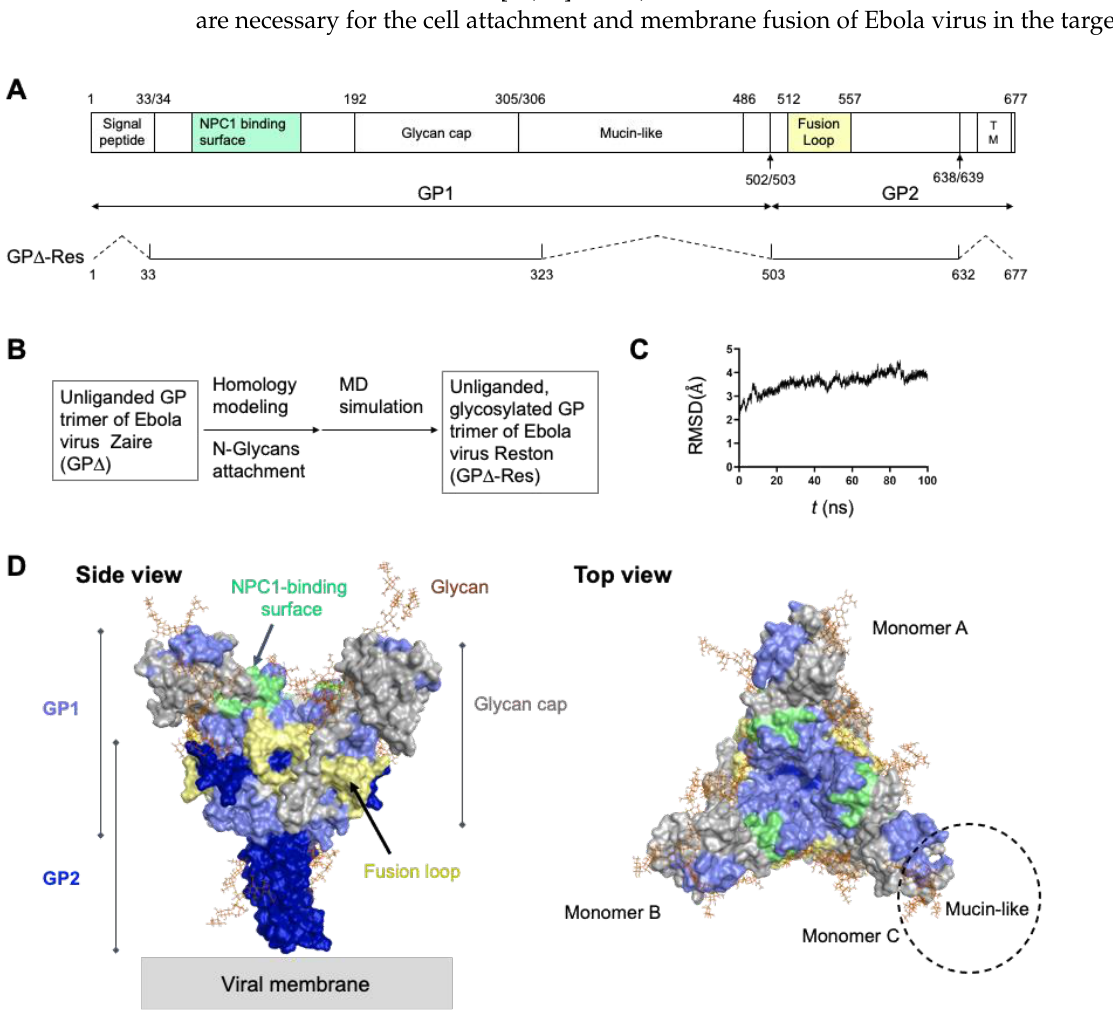
Figure 6. Molecular modeling of the unliganded, pre-fusion state of the glycosylated GPΔ -Res trimer of the Reston Ebola virus strain. The reported amino acid sequence of the spike glycoprotein of the Reston Ebola virus strain (GenBank accession number: AAC54885)[43] and the reported crystal structure of the ectodomain of the unliganded glycoprotein trimer of the Zaire Ebola virus strain at a resolution of 2.23 Å (PDB code: 5JQ3) [47] were used to construct a structural model of the GPΔ -Res trimer of the Reston Ebola virus strain by homology modeling followed by MD simulation, as described for the modeling of the trimeric envelope glycoproteins of other RNA viruses [44 – 46]. Gal 2 Man 3 GlcNAc 4 was added on the trimeric glycoprotein model before MD simulation based on previously reported information [48] using the Online Glycoprotein Builder web-tool GLYCAM-Web [49]. ( A ) Schematic of the structural organization of the Ebola virus glycoprotein. Dotted lines indicate regions absent in the modeling template GP Δ [47] and the Reston Ebola virus glycoprotein model (GP Δ -Res). Amino acid numbering is based on the Reston glycoprotein. ( B ) Overview of the GP Δ -Res modeling. ( C ) Root mean square deviations (RMSDs) between the initial model structure and the structures at given time points during the MD simulation. ( D ) Molecular surface model of a GP Δ -Res structure at 100 ns of MD simulations. Mucin- like domain is located on the frontal region of glycan cap of each glycoprotein monomer [93]. Light green and yellow portions indicate the binding surface of endosomal protein Neimann – Pick C1 (NPC1) and fusion loop, respectively. These structural units are proposed to be critical for the conformational changes and membrane fusion of the glycoproteins in endosomes [87 – 92].